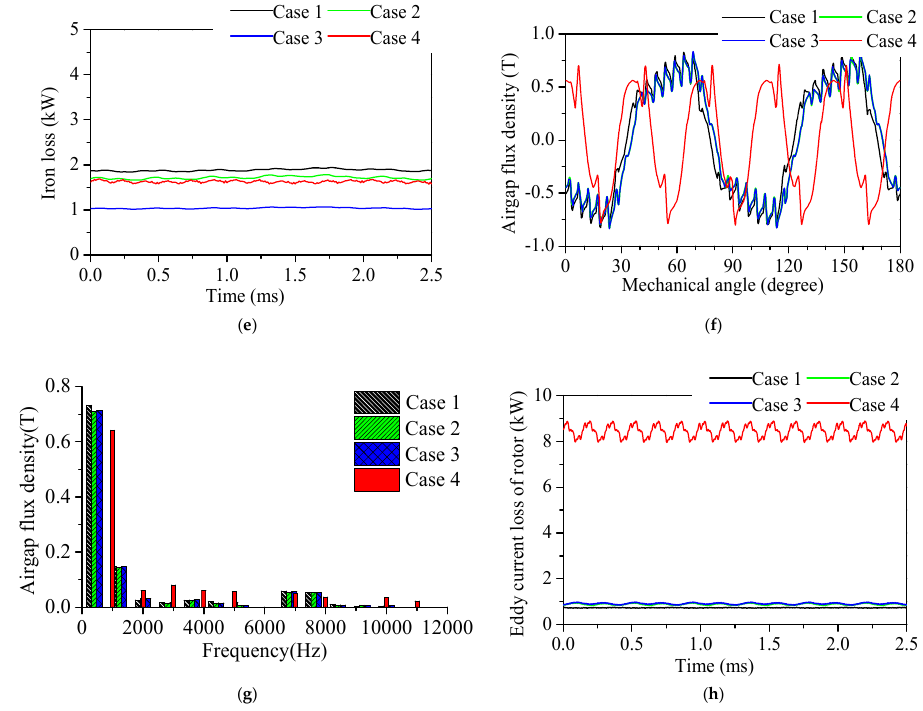
Figure 2. FEA models of prototypes with the distribution of flux lines and densities of, ( a ) Case 1 (15,226 triangle elements, time step: 2.5 × 10 − 6 S); ( b ) Case 2 (26,136 triangle elements, time step: 2.5 × 10 − 6 S); ( c ) Case 3 (26,136 triangle elements, time step: 2.5 × 10 − 6 S); ( d ) Case 4 (15,107 triangle elements, time step: 5 × 10 − 7 S); ( e ) Calculated (FEM) iron loss; ( f ) radial flux densities in the middle of airgap; ( g ) harmonic spectrum of radial flux density; ( h ) rotor eddy-current loss.